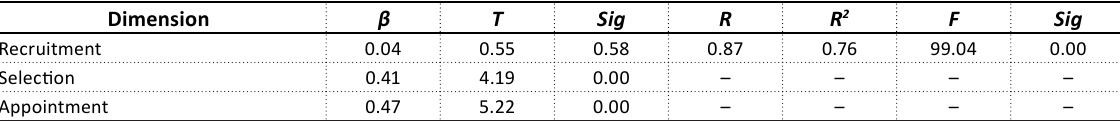
Table 4. Regression